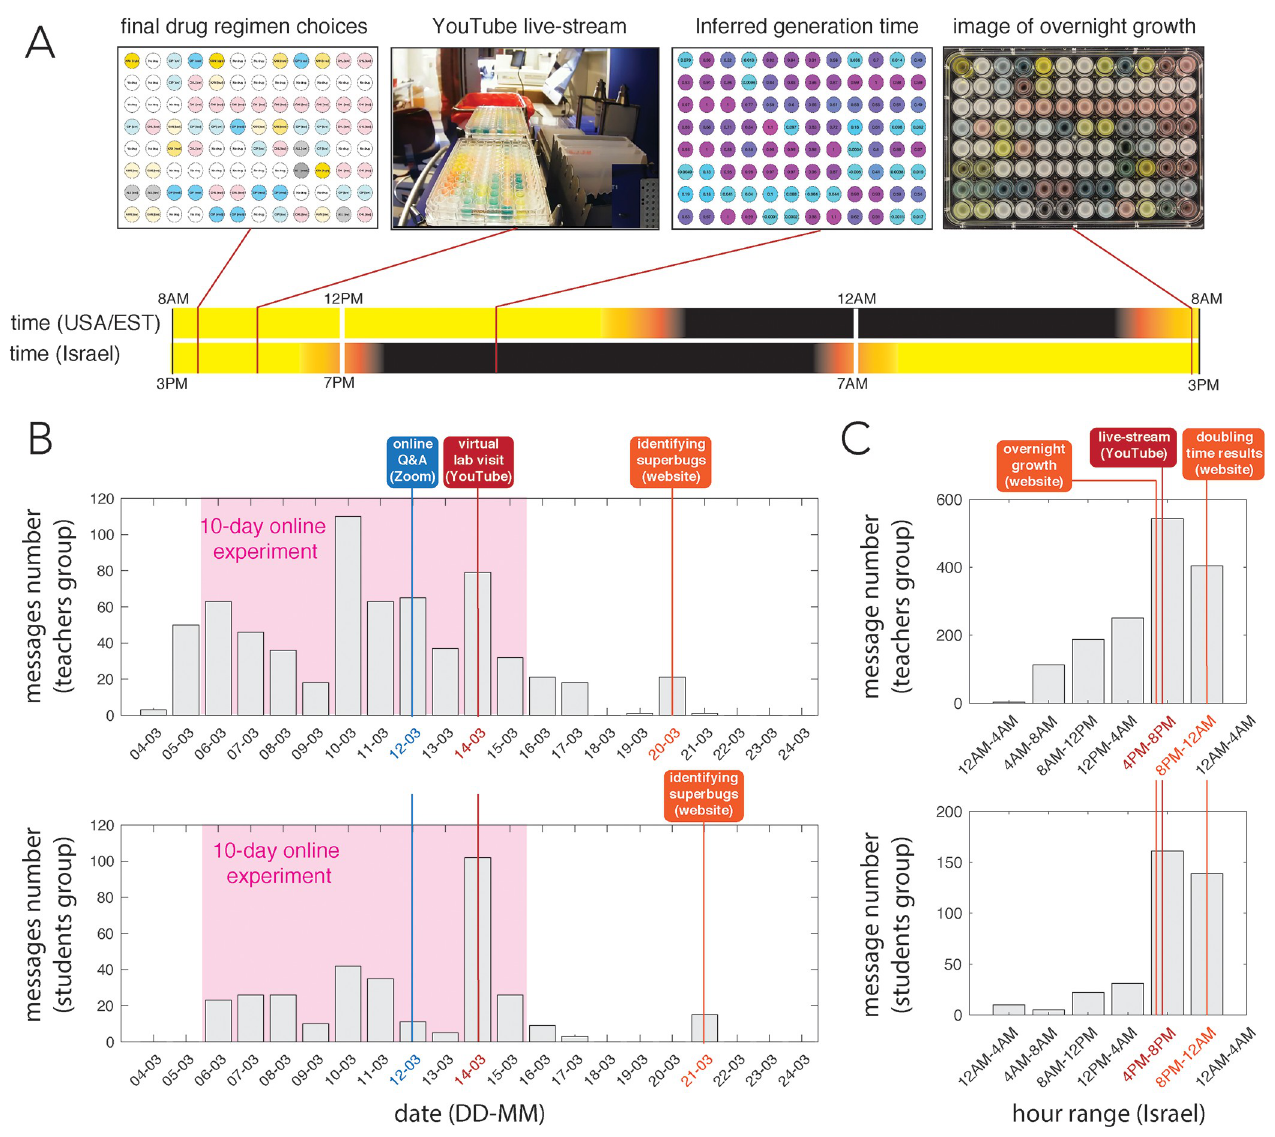
Fig 2. Daily interactions and information exchange during the evolution experiment. (A) The daily schedule and information sharing scheme between the research lab (USA) and the remote high schools (Israel). Drug regimen choices were made daily, and plate preparation and culture inoculation were streamed live over YouTube (the experiment continued over 10 consecutive days). Different antibiotics were spiked by inert color dyes to allow students to visually confirm the robotic liquid handler implemented the correct drug regimen. The research lab reported back the observed generation time and also posted a photograph of culture confluence to allow students to make informed decisions on the next day’s drug regimen. (B) Analysis of the social interactions in the discussion forum during the experiment showing overall increase in the number of messages during the 10-day experiment. Online events, such as a virtual lab visit, had notable effects on the number of interactions. The “identifying superbugs” results were shared with teachers a day before the students. (C) Analysis of social interactions timing. The analysis reveals many of the interactions occurred after school hours and correlated with important daily events. Q&A, question-and-answer